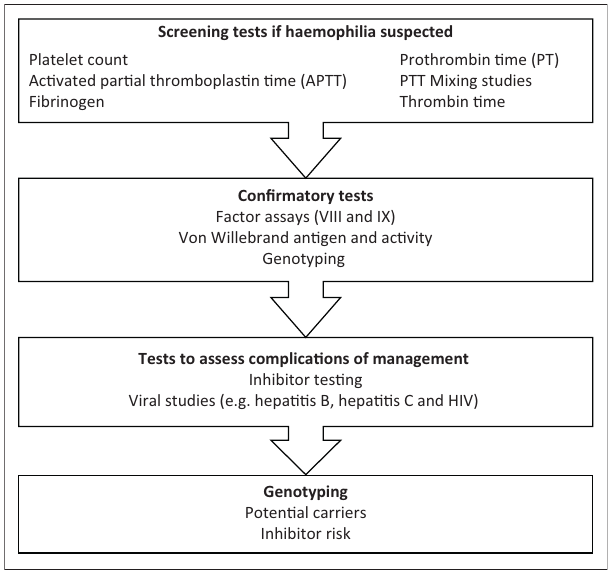
FIGURE 4: Laboratory approach to a patient suspected of having haemophilia.